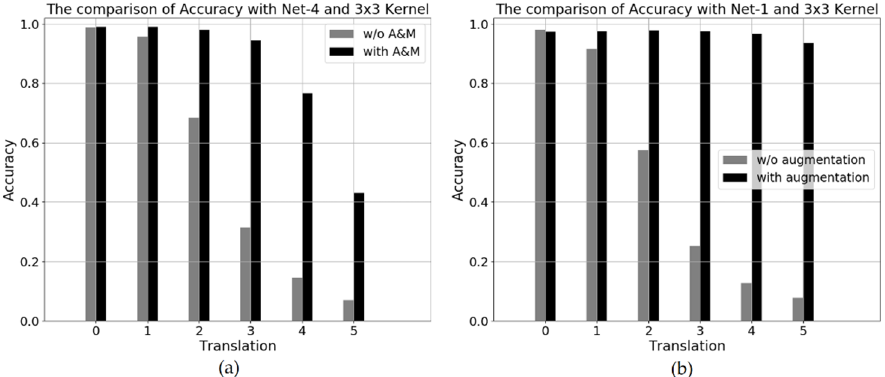
Figure 9. The comparison of networks with the same 3 × 3 kernel size. ( a ) for the Net-4 network with and without both max-pooling and augmentation (A&M) within 2-pixel translation. ( b ) for the Net-1 network with and without augmentation within 5-pixel translation.